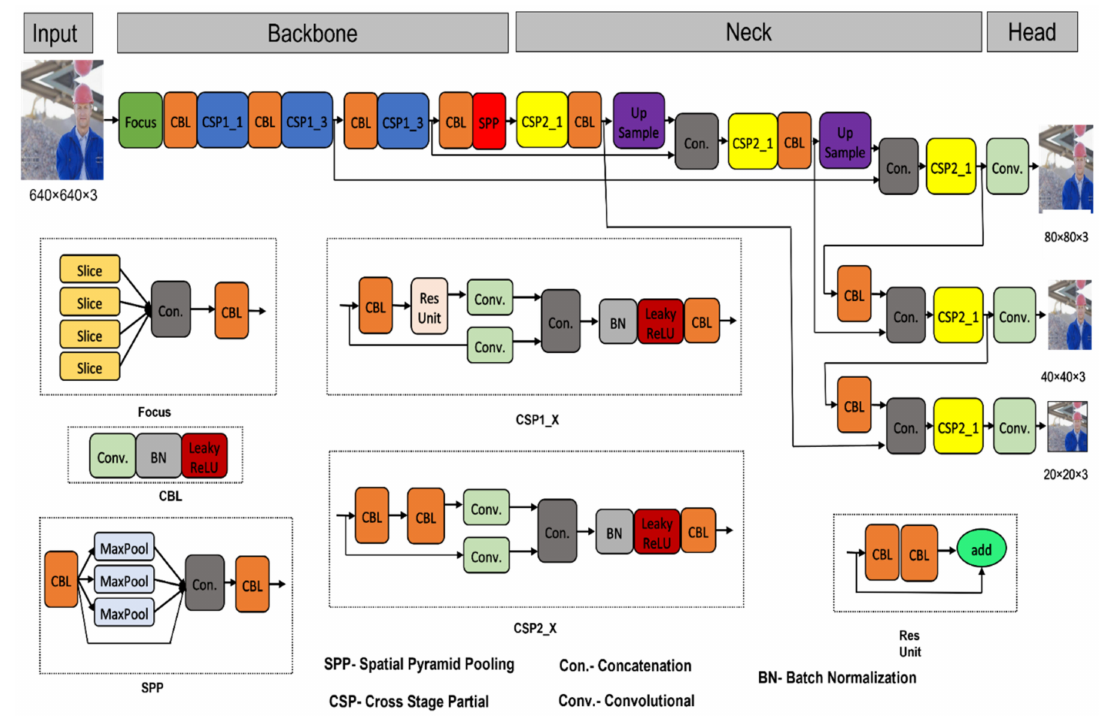
Figure 5. Architecture of YOLOv5 for Safety Helmet